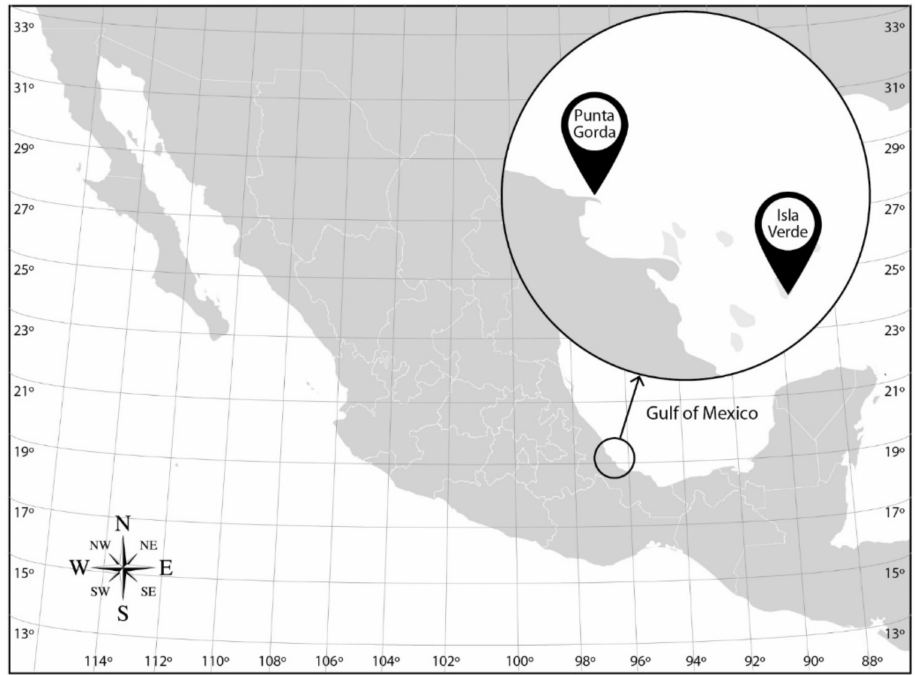
Figure 1. Sampling sites for bacterioplankton and bacteriobenthos from the Veracruz Reef System (VRS) on the Gulf of Mexico